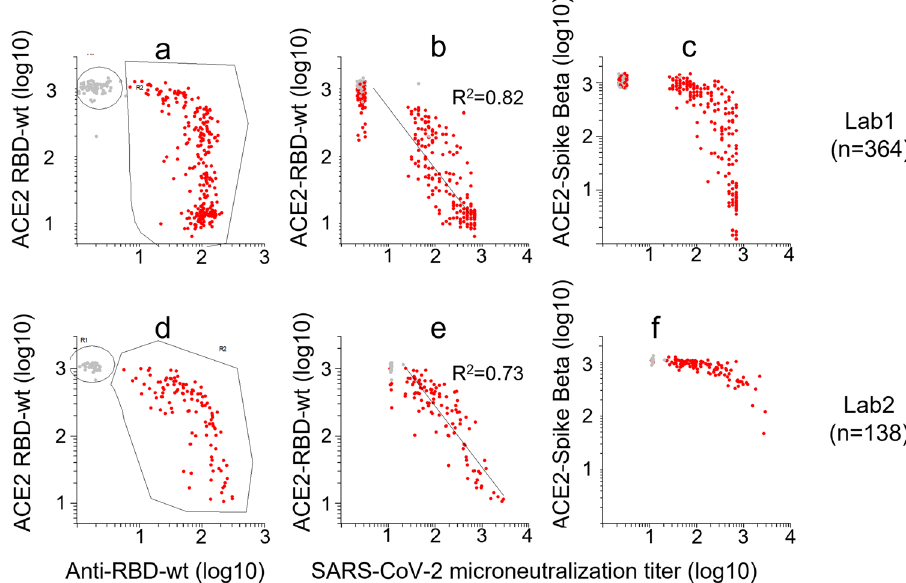
Fig. 3 Validation of RBD-ACE2 interaction assays. A total of 502 sera that had been tested for neutralizing activity against SARS-CoV-2 were analyzed with Multi-IgG-ACE2-RBD. Each dot in the scatter plots corresponds to a different sample. a , d : The x - and y -axes show binding of IgG- ( x -axis) and ACE2 to beads that had been incubated with sera. b – c: the x-axis shows virus neutralization titers against SARS-CoV-2wt measured for 364 sera in Oslo. The y -axes show ACE2-binding to RBDwt ( b ) or spike-Beta ( c ). e – f : the x -axis shows virus neutralization titers against SARS- CoV-2wt measured for 138 sera in Bergen. Source data are provided as a Source Data fi